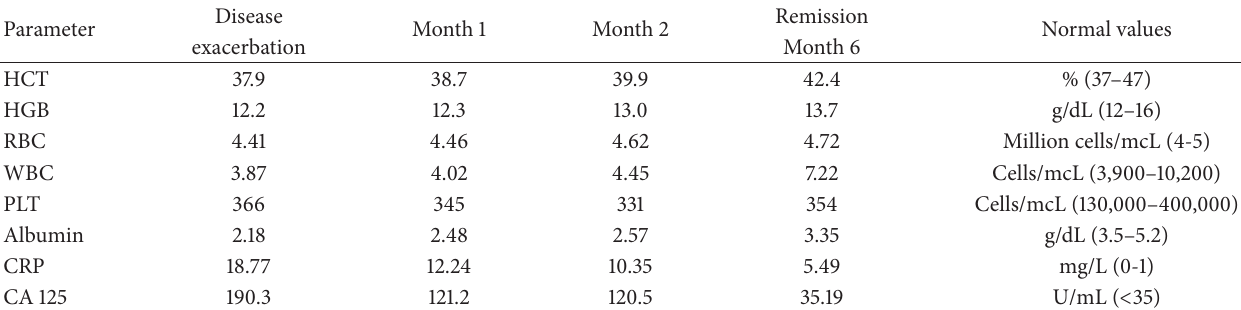
Table 1: Results of laboratory tests during exacerbation of the disease, follow-up, and clinical remission.